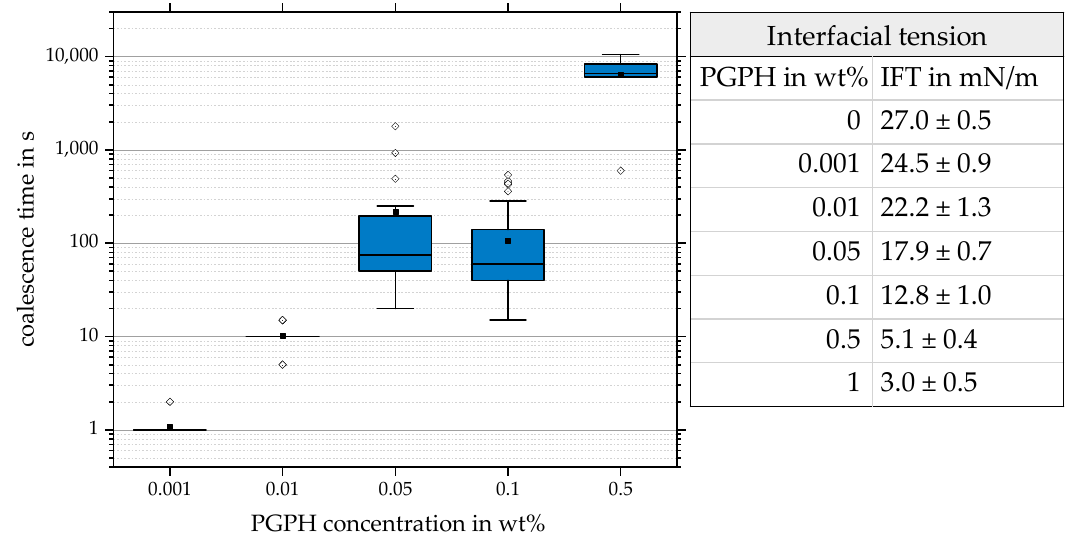
Figure 4. Coalescence times of water droplets with increasing amount of PGPH. The corresponding interfacial tension values are shown in the table on the right. Boxplot symbols as described in Figure 3.